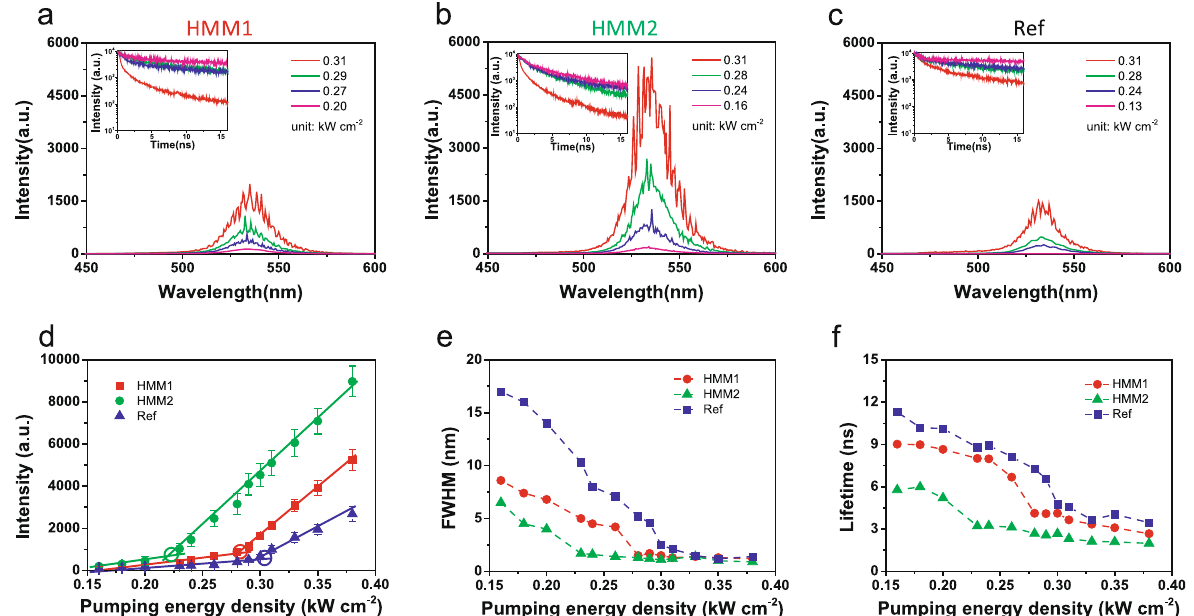
Fig. 2 Emission dynamics of random laser action for the HMM structure. a – c The emission spectra of the PNCs on top of the HMM1, HMM2, and glass substrate, respectively. The emission spectra were measured at four kinds of pumping power density, high power density (0.31 kW cm − 2 ), medium power density (0.23 – 0.29 kW cm − 2 ), and low power density (0.13 – 0.20 kW cm − 2 ) to realize the power-dependent emission spectra as a critical realization of the laser action. All the measured emission spectra were excited using a 374 nm pulsed diode laser. The insets are the corresponding lifetime measurements. d The maximum lasing peak emission intensity as a function of pumping energy density. The slow rising slope is the ampli fi ed spontaneous emission, the drastic slope is the stimulated emission, and the intersection represents the lasing threshold (hollow circle). For the HMM1 (HMM2 and glass substrate), the lasing threshold is 0.27 (0.22 and 0.30) kW cm − 2 . Error bars are the standard deviation of spectra fl uctuation of random laser action from 15 datasets. e The corresponding full width at half maximum (FWHM) and f the averaged lifetime as a function of pumping energy